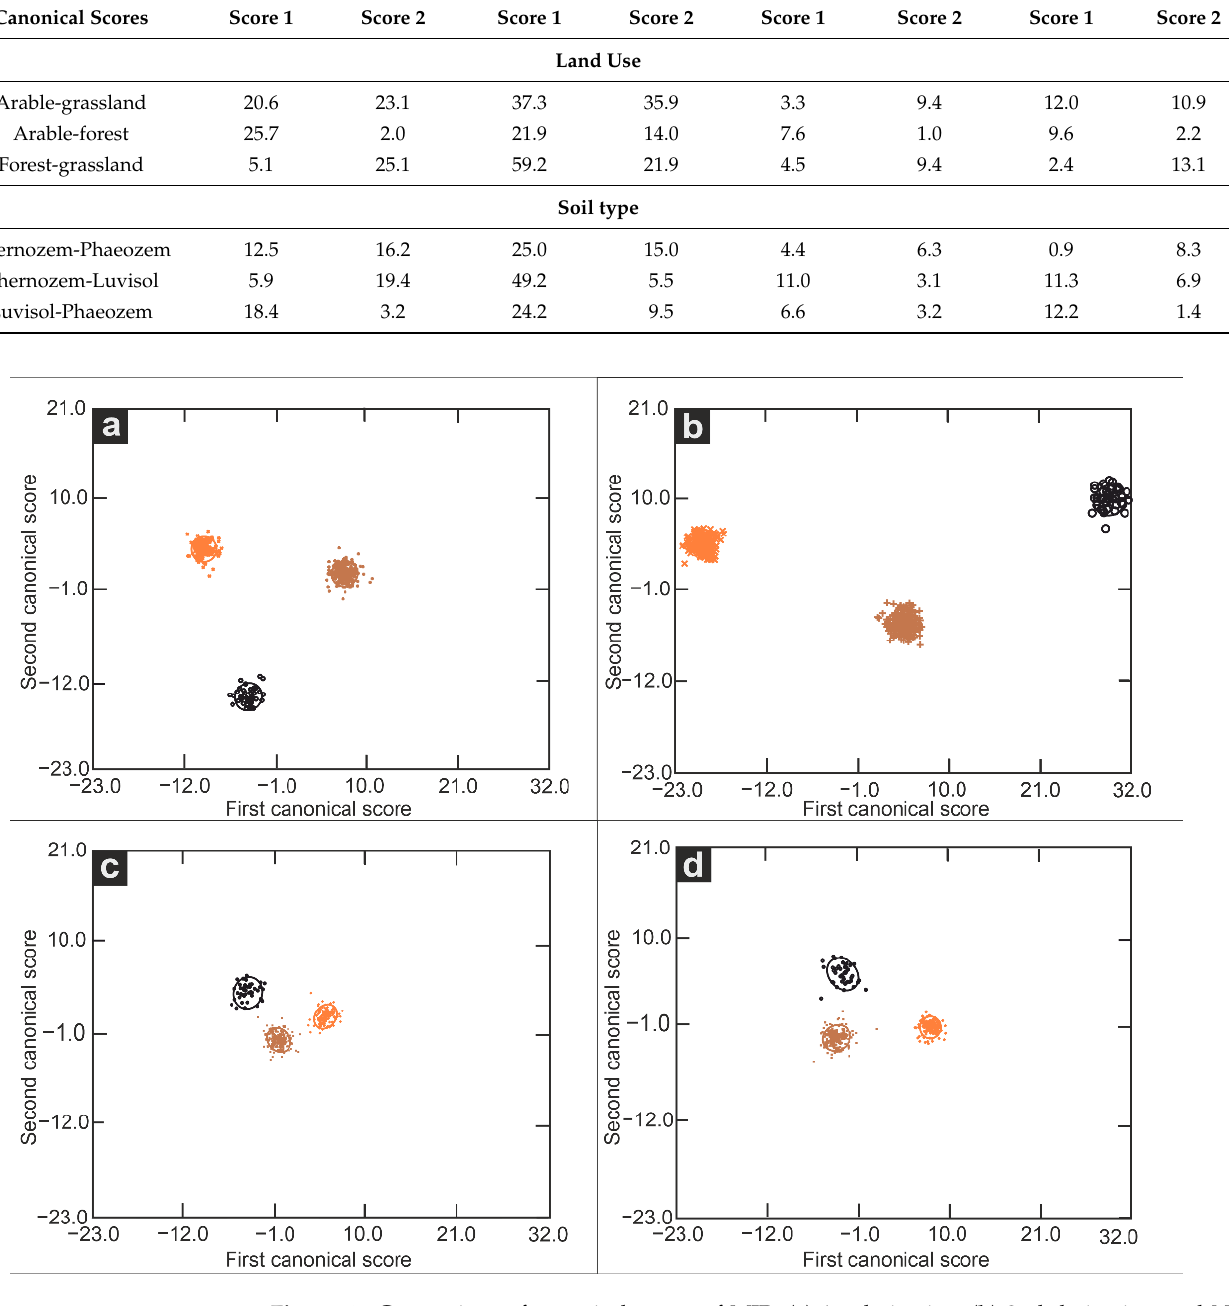
Figure 4. Comparison of canonical scores of MIR: ( a ) 1st derivative, ( b ) 2nd derivative, and NIR ( c ) 1st derivative, ( d ) 2nd derivative. Soil type: black — Chernozem, brown — Phaeozem, orange — Luvisol.